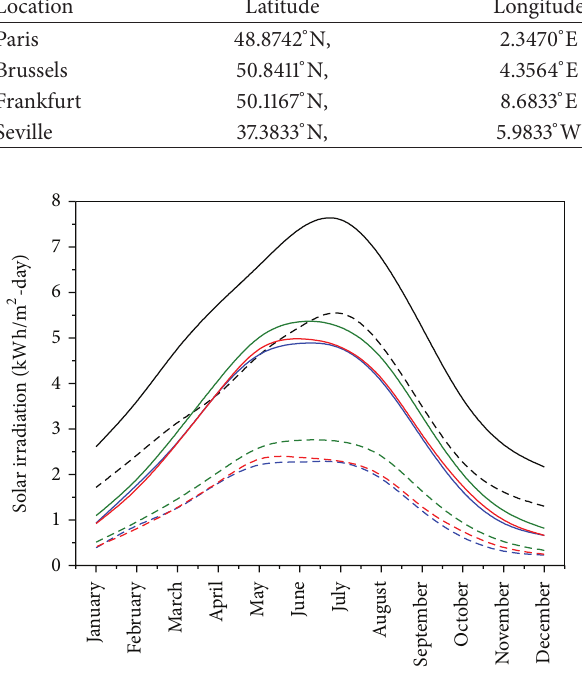
Figure 2: Calculated values of total ( 𝐻 ) and direct ( 𝐻 𝑏 ) irradiation for different locations: Seville (SVQ, ES), Frankfurt (FRA, DE), Paris (PAR, FR), and Brussels (BRU, BE)